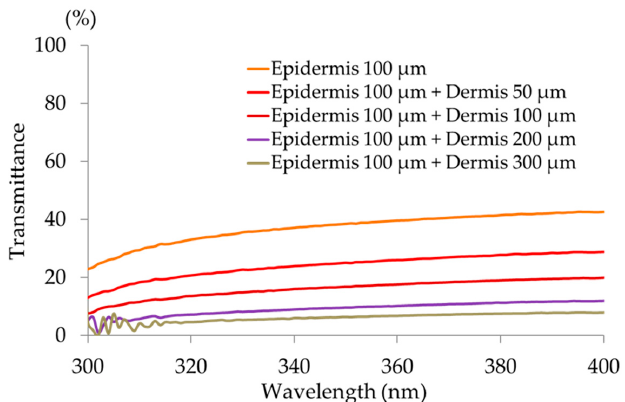
Figure 3. Skin transmittance of different wavelengths of UV radiation. Table 3. Relationship of the depth of the skin transmissivity of UVB and UVA radiation.